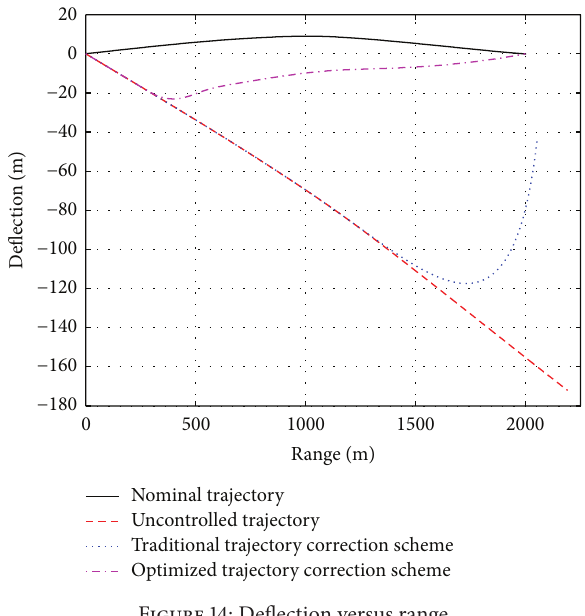
Figure 14: Deflection versus range.